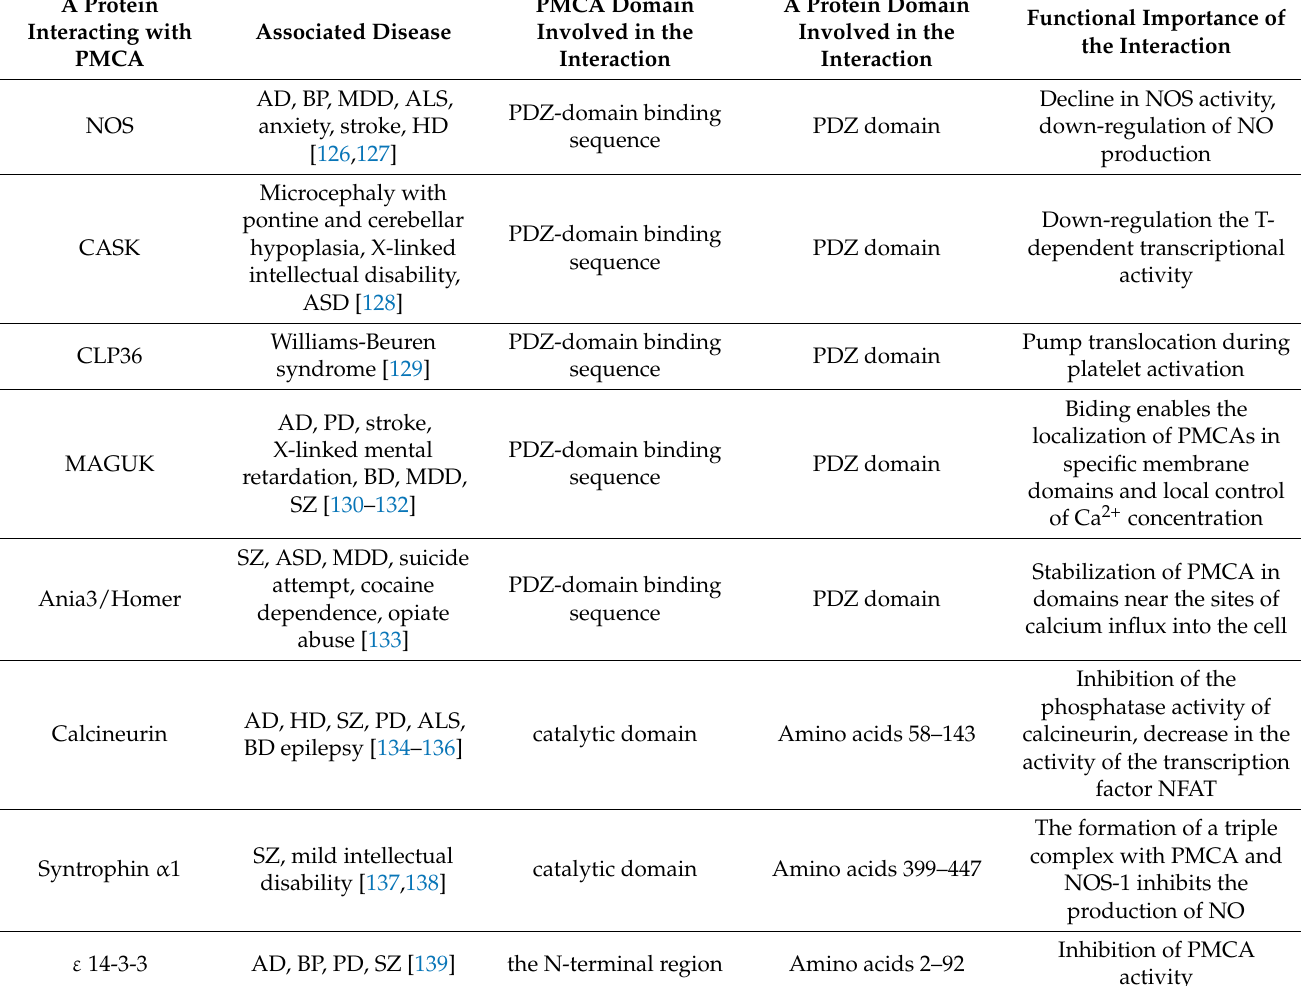
Table 3. Protein interacting with PMCA. Modified based on [125]. AD—Alzheimer’s disease; BP—bipolar disorder; HD— Huntington’s disease; PD—Parkinson’s disease; SZ—schizophrenia, MDD—major depressive disorder, ALS—amytrophic lateral sclerosis, ASD—autism spectrum